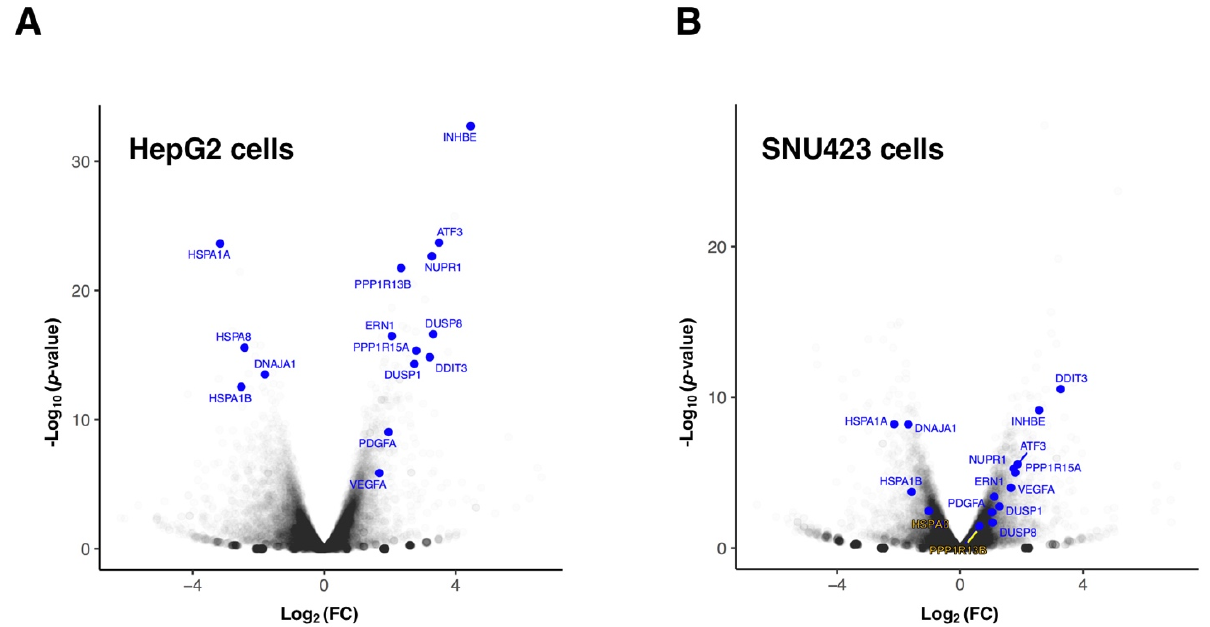
Figure 2. Differentially expressed genes in HepG2 ( A ) and SNU423 ( B ) cells upon Sorafenib treatment (10 µM, 12 h) detected using RNA-seq. The Volcano plot illustrates selected transcripts that show significant misregulation. The p -values are plotted in a − log 10 format as y-values and fold change of the mRNAs are plotted in a log 2 format as x-values. Representative transcripts that showed significant differential expression are indicated (blue). The rest of genes are shown in grey; density of genes is represented by a darker grey intensity.